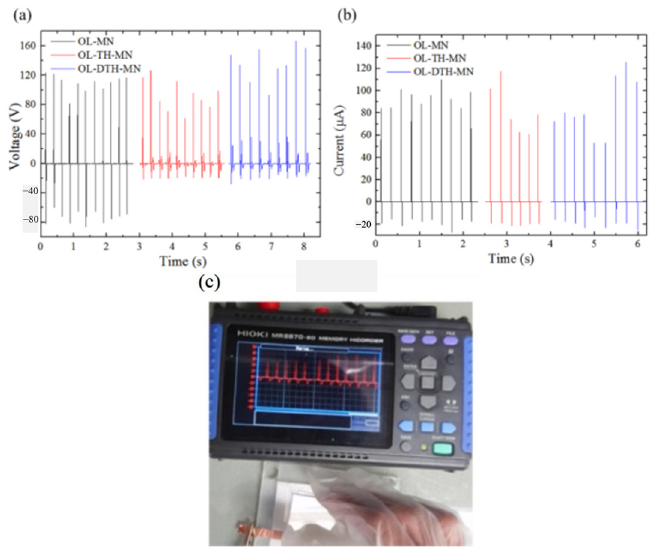
Figure 21. The TENG voltage waveform from cycling contact and separation test, and performance measurement using recorder [130]. ( a ) voltage and ( b ) current was measured of the different TENG during the real-time hand tapping, and ( c ) the image of TENG and measurement device through external force.